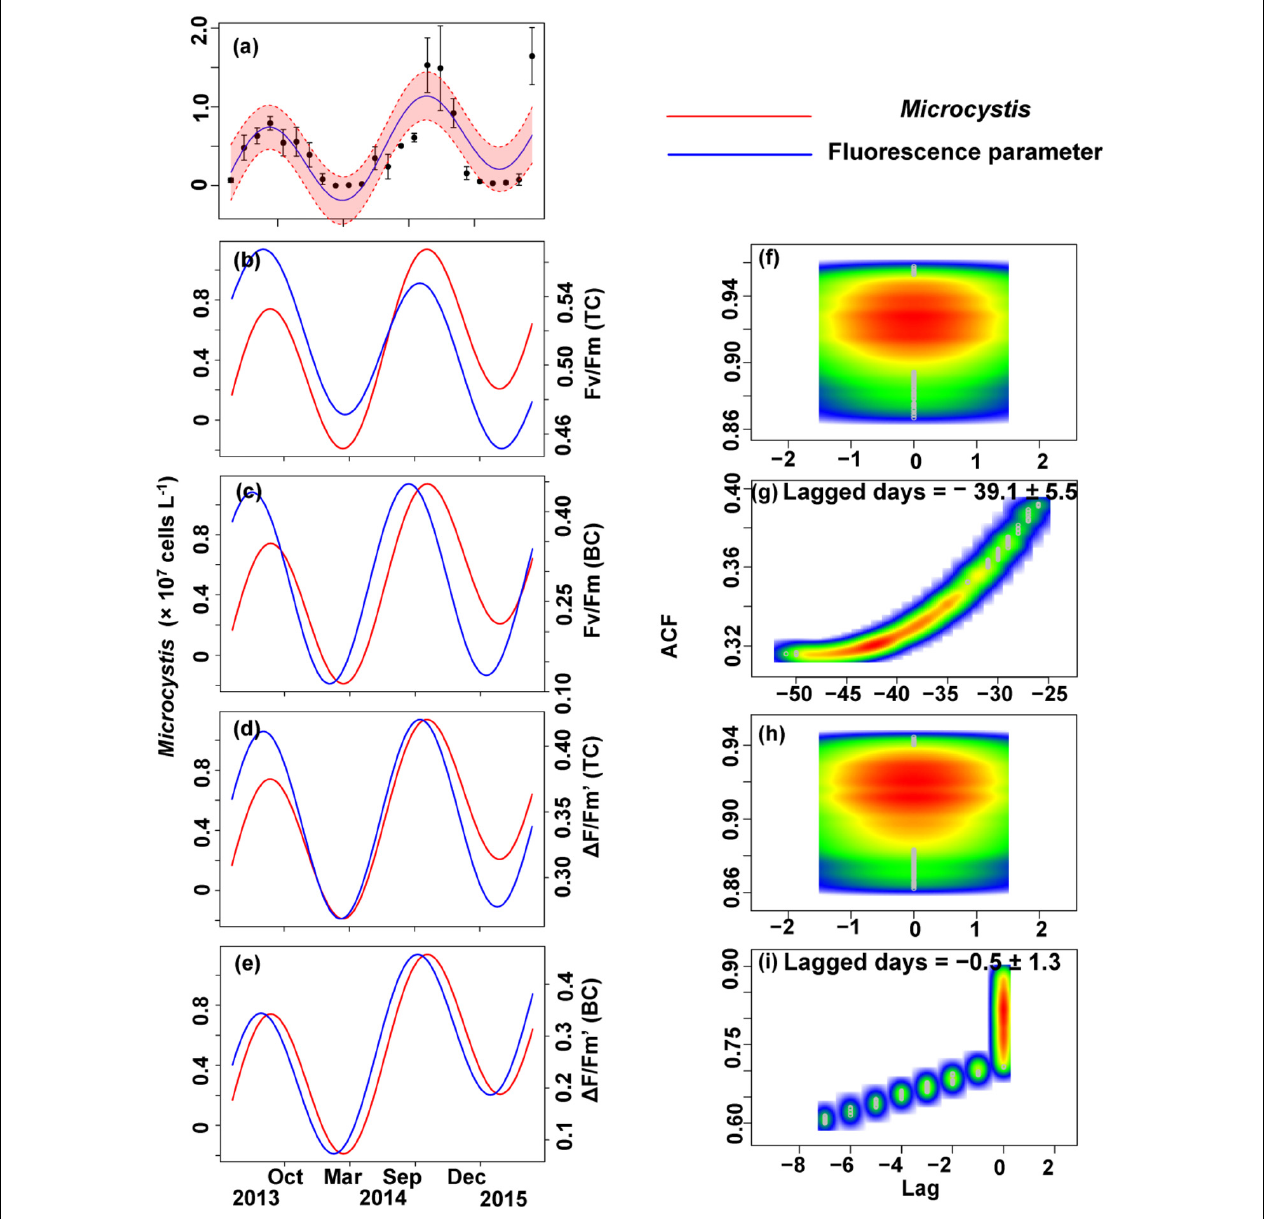
FIGURE 8 | Trigonometric regression of the Microcystis cell density (a) and fluorescence measurements [ F v / F m (TC) (b) , F v / F m (BC) (c) , (cid:49) F / F m (cid:48) (TC) (d) , and (cid:49) F / F m (cid:48) (BC) (e) ]. We fitted these seasonal trends with a time-lag analysis [ F v / F m (TC) (f) , F v / F m (BC) (g) , (cid:49) F / F m (cid:48) (TC) (h) , and (cid:49) F / F m (cid:48) (BC) (i) ]. The legged days and associated standard deviation among sites is shown in each